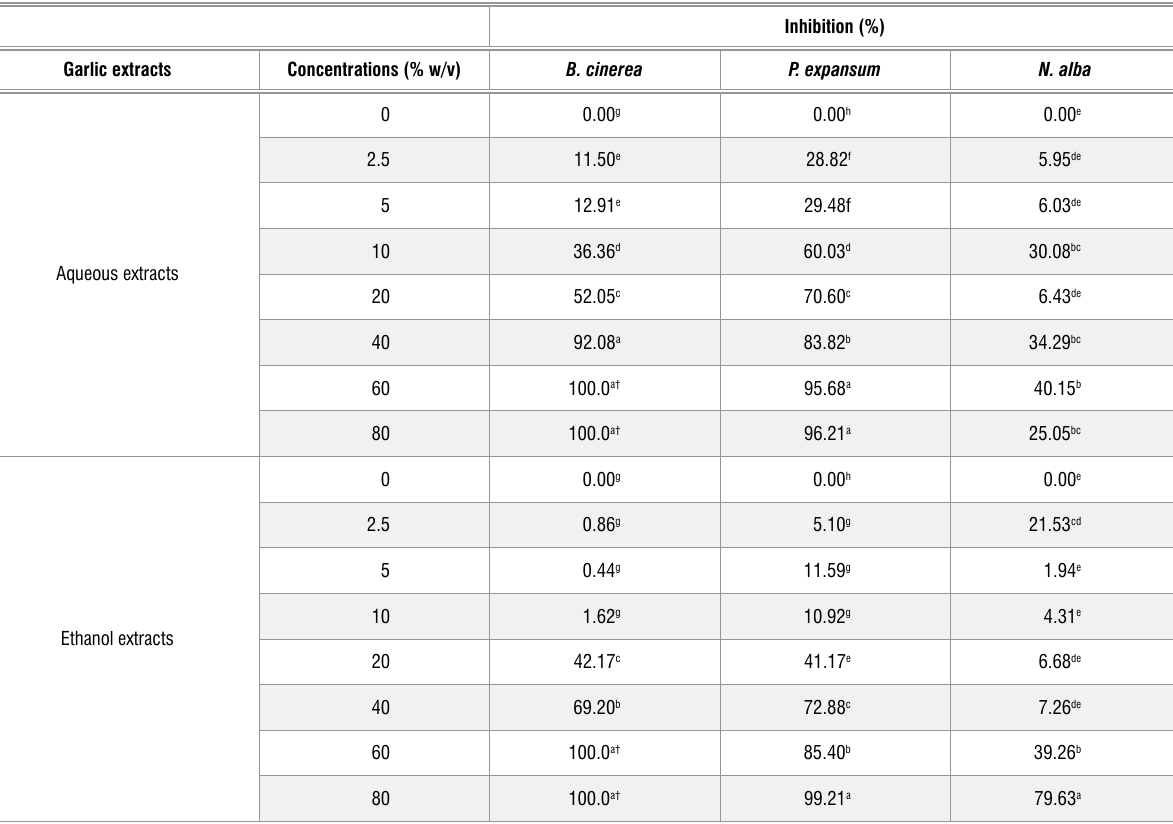
Values represent means of measurements made on three independent plates per treatment. In each column, values followed by the same letter do not differ significantly ( p <0.05), as determined by a Student’s t